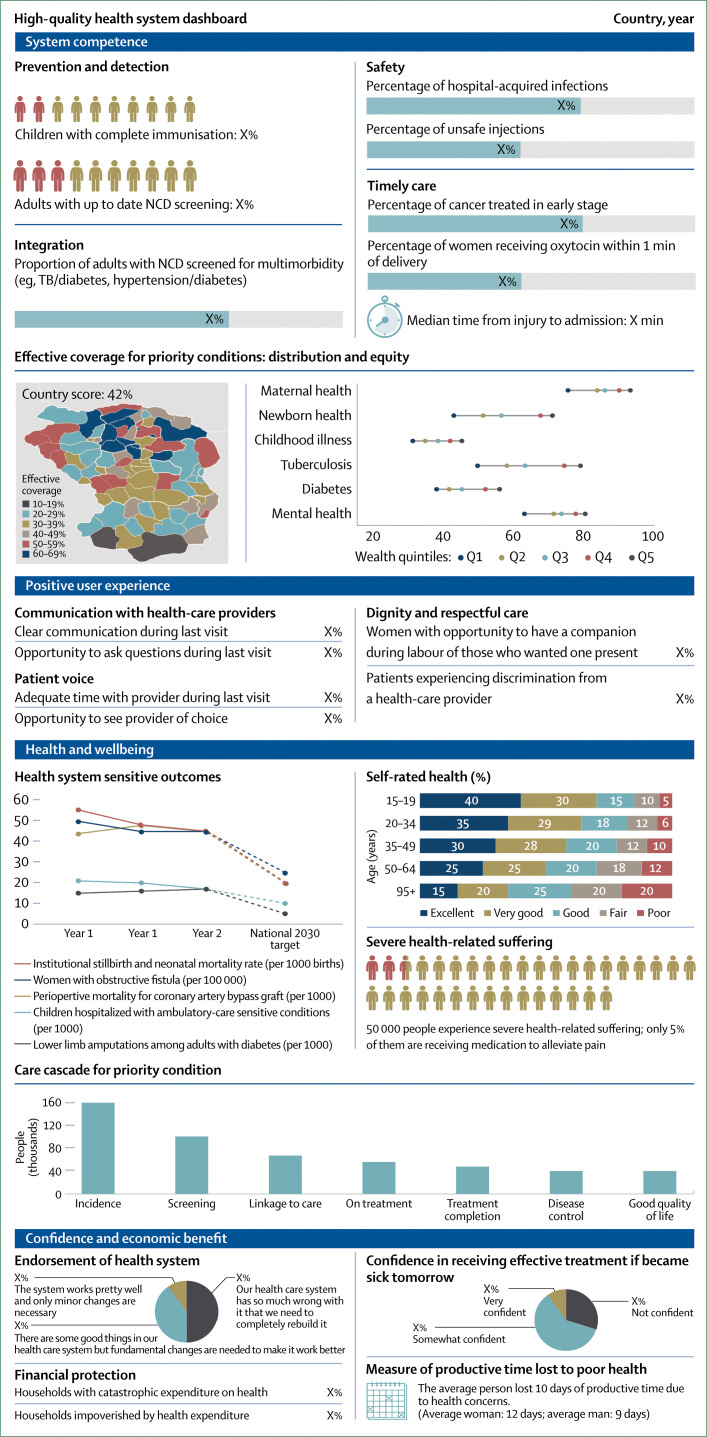
Sample high-quality health system dashboard with illustrative indicators